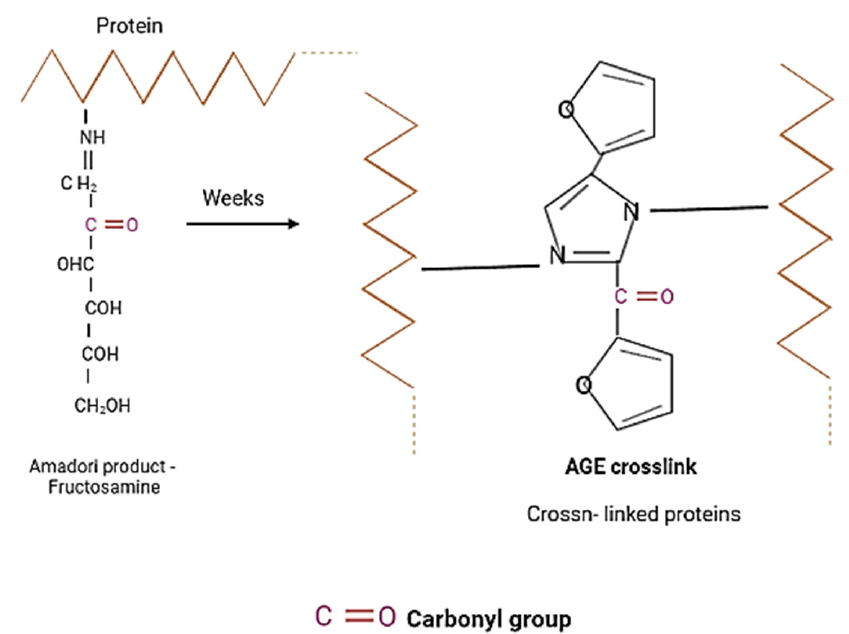
Figure 15. As a result of the glycation of albumin, the number of carbonyl groups increases. The Schiff’s base is changed into the more stable product Amadori (fructosamine), which is transformed into advanced glycation end-products (AGEs) through slow and complex reactions.